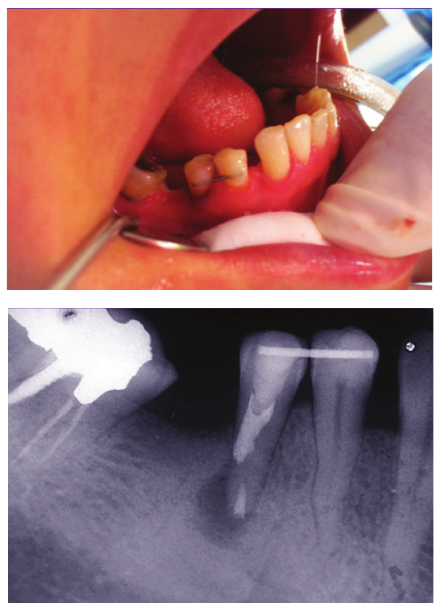
Figure 5: After replantation, the tooth was immobilized with a semirigid splint for 10 days.